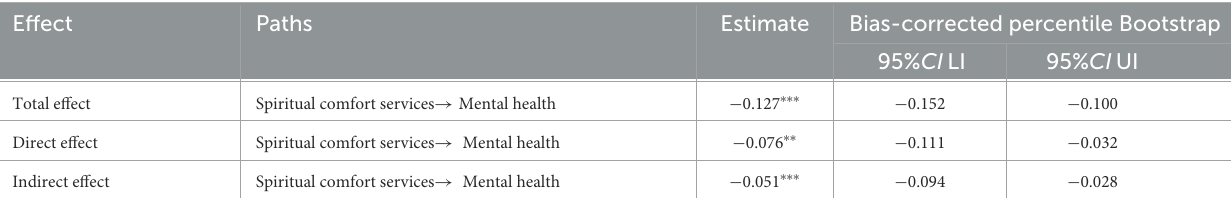
TABLE 8 Bootstrap model test